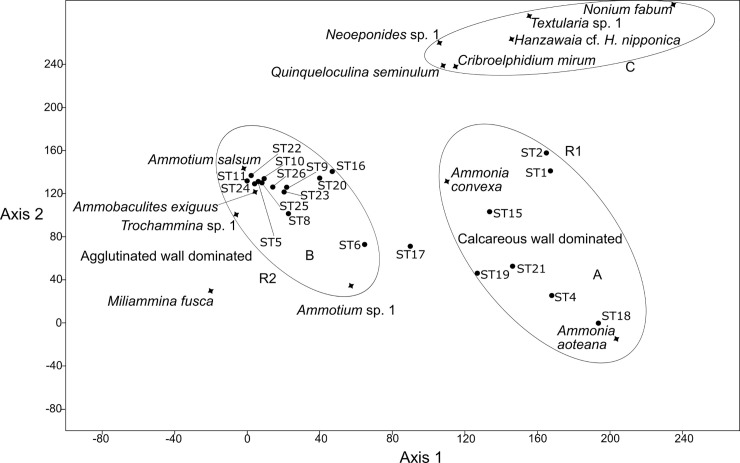
Detrended correspondence analysis of the benthic foraminiferal species recovered from the Lagos Lagoon (A, B and R1, R2 refer to the assemblages defined in Figs 6 and 7).